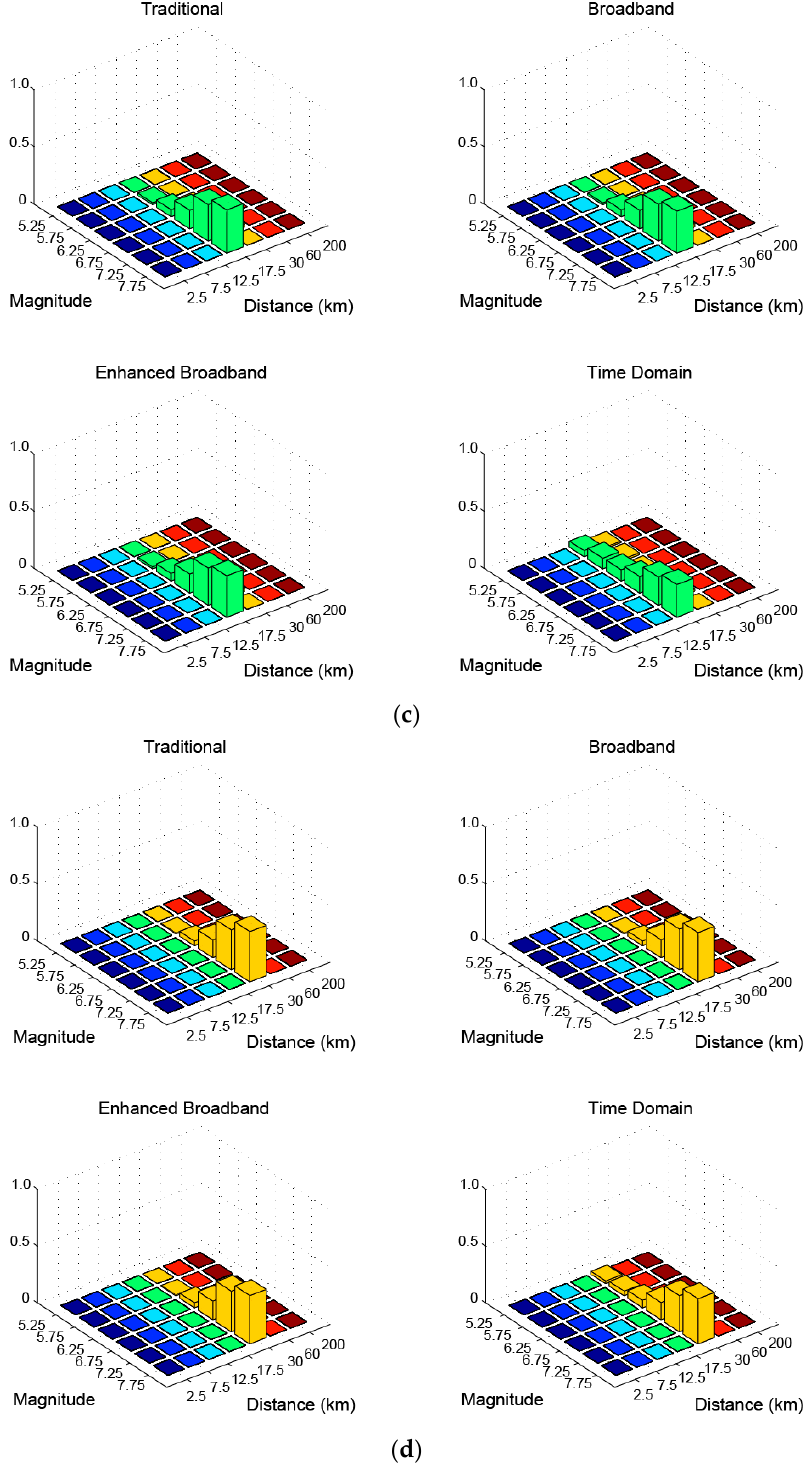
Figure 15. Magnitude-distance deaggregation at a drift angle of 1% from the four methods at distances of ( a ) 6 km, ( b ) 11 km, ( c ) 16 km and ( d ) 21 km from the fault centerline.